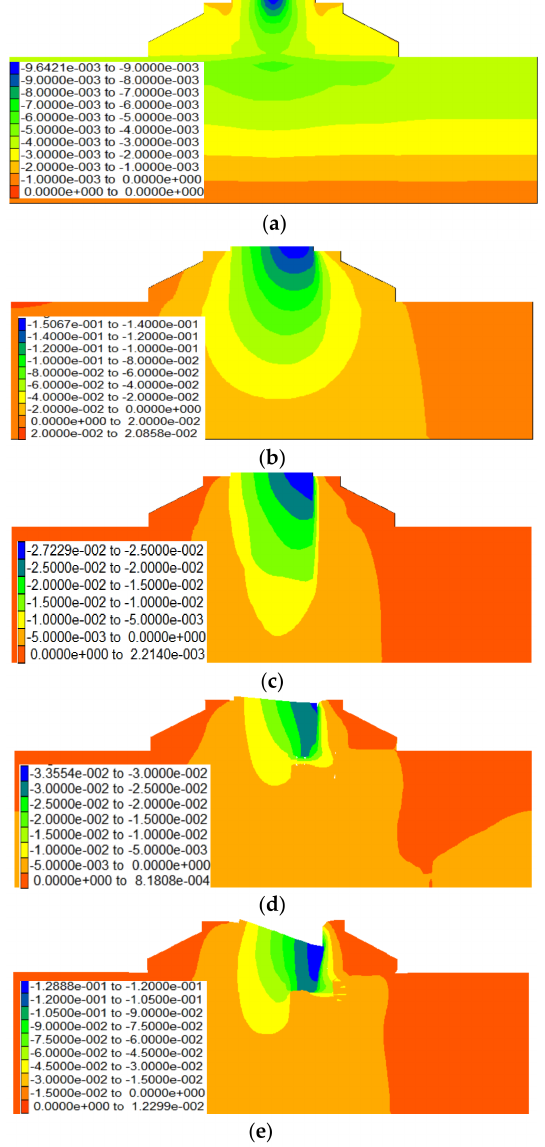
Figure 8. Vertical displacement distribution under various working conditions: ( a ) Without con- sidering wind load, creep, and fracture; ( b ) considering wind load without creep and fracture; ( c ) considering wind load creep without fracture ( t = 18 h); ( d ) considering creep fracture under wind load ( t 0 = 26.2 h); ( e ) considering creep fracture under wind load ( t F = 27.1